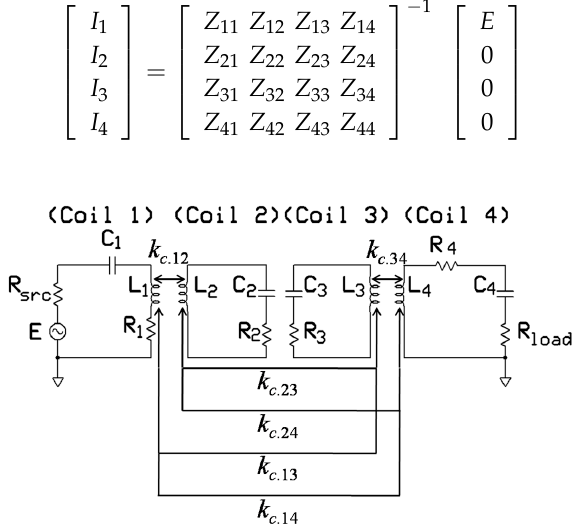
Figure 6. Simplified electric model of the four -coil PTE system.